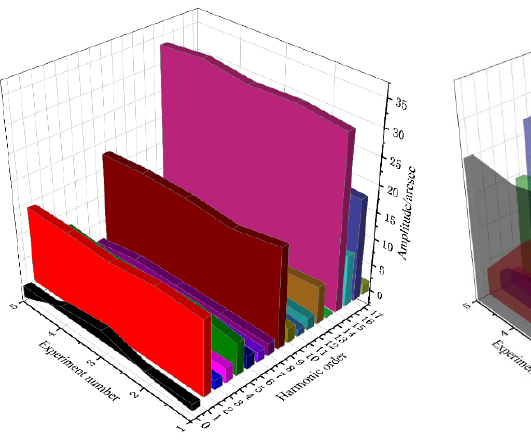
Figure 4. Original experiment error of joint modules: ( a ) joint module a; ( b ) joint module